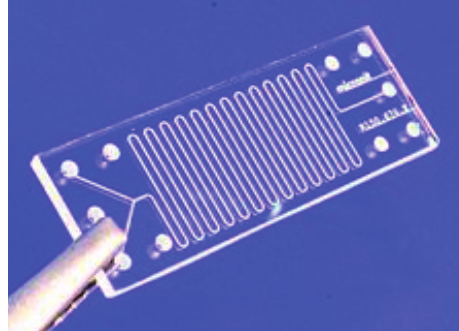
Figure 6. Lab-on-a-chip made of glass [127] under license © Micronit/Wikimedia